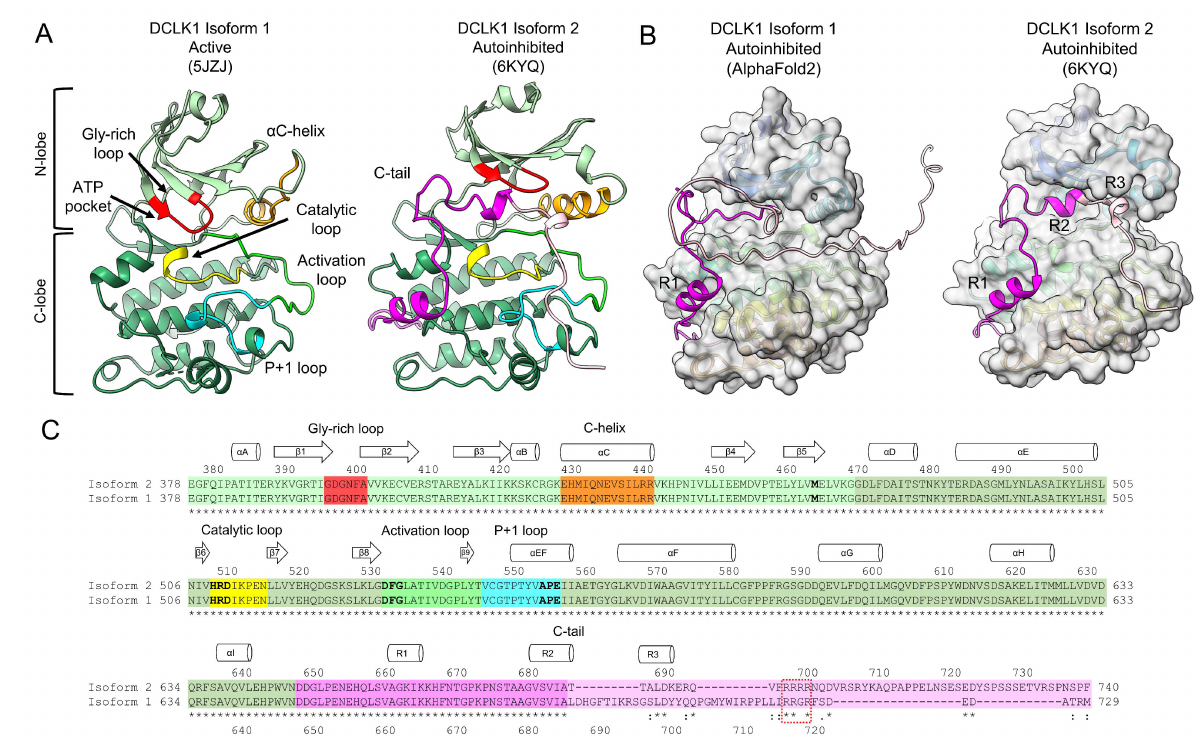
Figure 4. The structure and conformations of the DCLK1 kinase domain: ( A ) cartoon representation of DCLK1 structures in the active conformation (left, isoform 1, PDB ID: 5JZJ) and autoinhibited conformation (right, isoform 2, PDB ID: 6KYQ), with the N-lobe (light green) and C-lobe (olive green) indicated. Catalytic and regulatory regions are highlighted: the glycine rich loop (red), α C-helix (orange), the catalytic loop (yellow), the activation loop (green), the P + 1 loop (cyan), and the C-tail (purple/pink); ( B ) comparison of the C-tail structure predicted by AlphaFold2 [63,64] for isoform 1, and the auto-inhibited structure of isoform 2. The kinase domains are depicted in a surface representation excluding the C-tail portion. The three regulatory helices of the C-tail (R1, R2, R3) are indicated; and ( C ) sequence alignment of DCLK1 isoforms 1 and 2 colored according to assigned function as in ( A ). Key functional motifs are bolded: the gatekeeper residue (M465), HRD-motif in the catalytic loop, DFG-motif in the activation loop, and the APE-motif in the P + 1 loop. Secondary structure is shown for isoform 2. The Arginine (R) rich region in the C-tail is partially conserved (dashed box). Sequence alignment performed using PROMALS3D [84] and structures rendered in UCSF ChimeraX v1.5